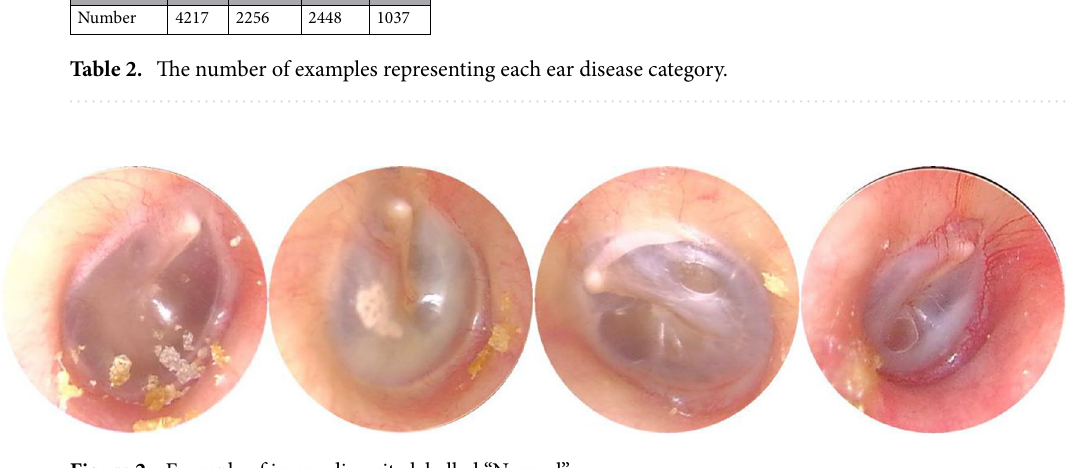
Figure 2. Example of image diversity labelled